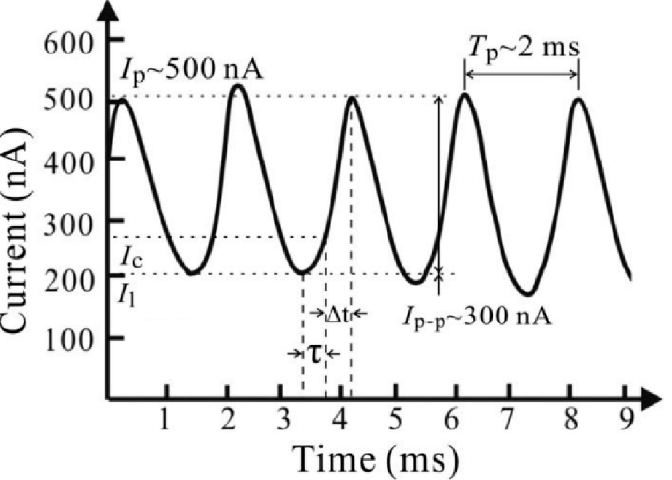
Figure 14. The sine-form oscillating current from field emission of an individual ZnO nanowire. Reproduced from [65], with the permission of AIP Publishing, 2009.